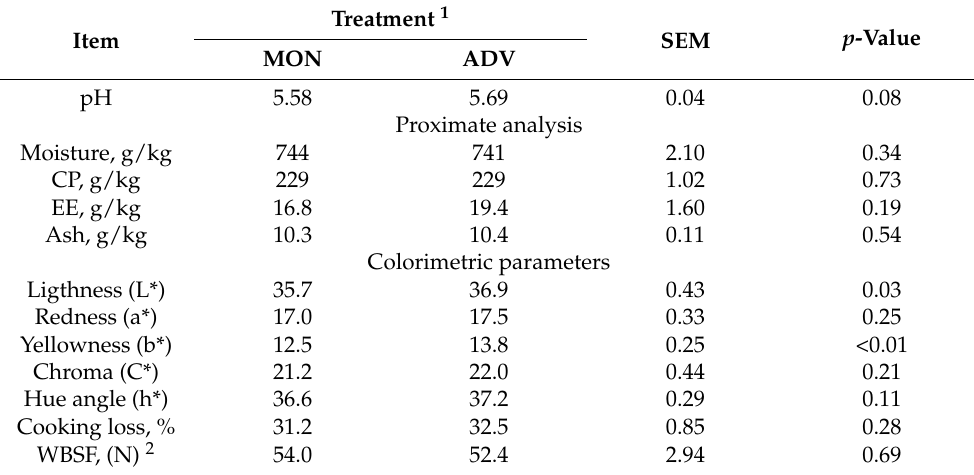
Table 7. Meat characteristics of Nellore bulls finished on pasture with high concentrate supplementa- tion, with monensin (MON) or a blend of live yeast and organic minerals (ADV).